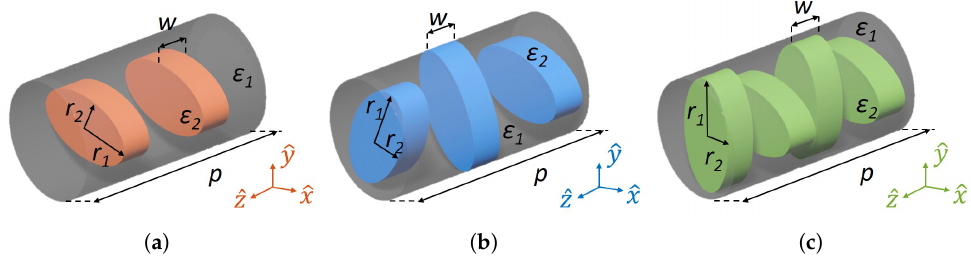
Figure 1. Dielectric rod embedded with ( a ) 2-, ( b ) 3- and ( c ) 4-fold twist-symmetric elliptic